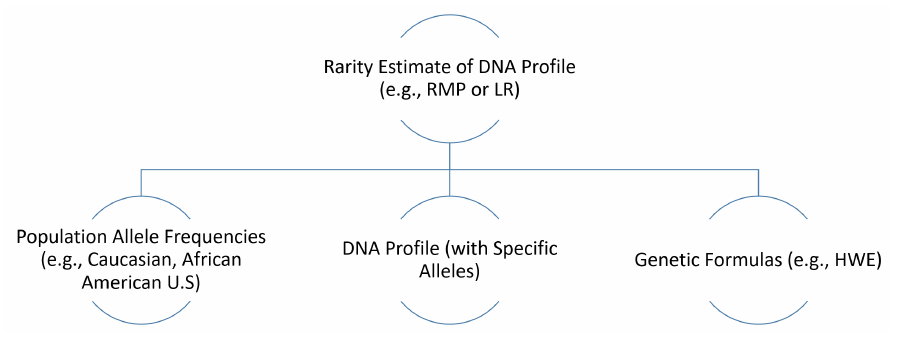
Figure 10. Rarity